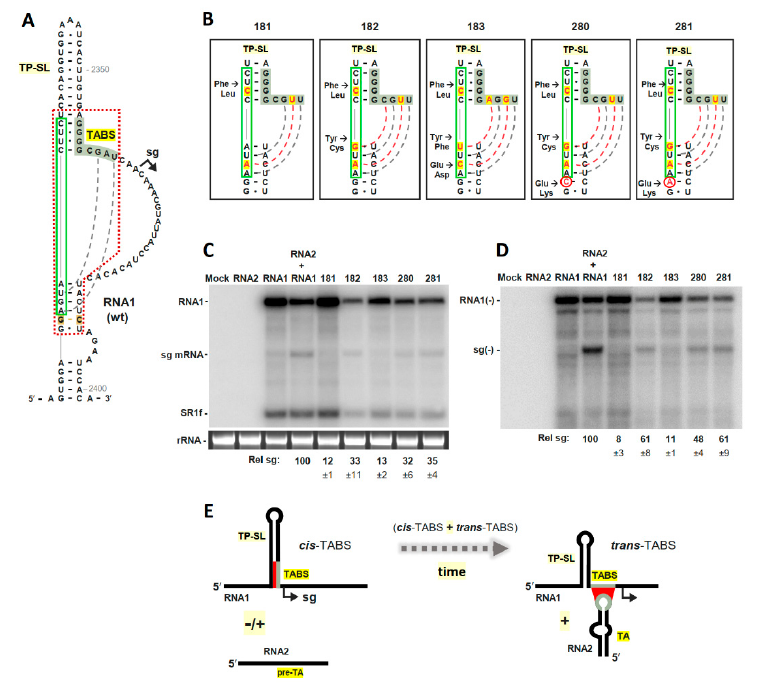
Figure 4. Modifying the structural context of the TABS in RCNMV RNA1. ( A ) Structure of the TP- SL/TABS region in wt RCNMV RNA1. The potential partner sequence for the TABS is boxed in green, with existing base pairs indicated by the grey dotted line. The red dashed line defines the regions shown in ( B ). ( B ) RNA1 TP-SL/TABS mutants with nucleotide substitutions are depicted in red with yellow highlighting. Additional substitution mutations made in 182 (to generate 280 and 281) are circled in red. Intended base-pairing is shown by dotted lines for new (red) and existing (grey) partners. Amino acid changes are indicated to the left. ( C ) Northern blot analysis of wt plus-strand RNA1 and TP-SL/TABS mutants in plant protoplast transfections (n = 3). Loading controls (rRNA) are also shown. ( D ) Northern blot analysis of minus-strand RNA1 accumulation in plant protoplast transfections (n = 3). ( E ) Simplified depiction of the evolution of sg mRNA transcription from RNA1. Base pairing leading to sg mRNA transcription is depicted in red. See text for